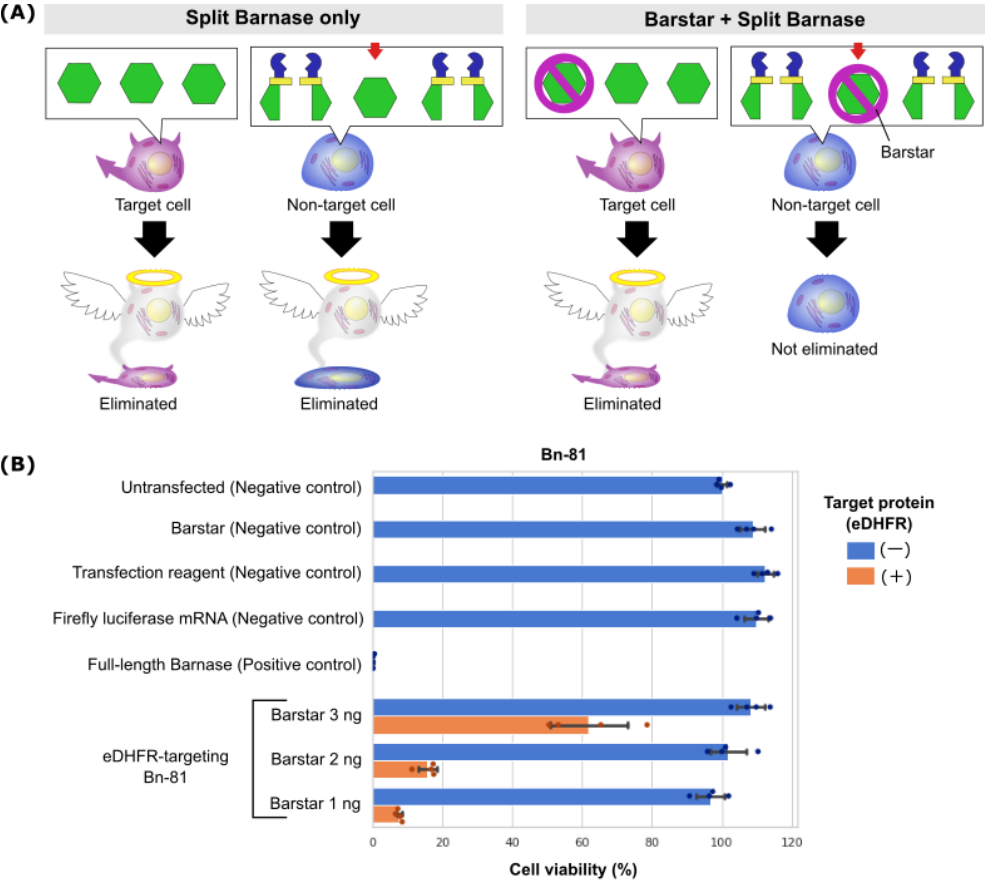
Figure 3. Reduction of off-target cytotoxicity by cotransfection of Barstar. ( A ) Schematic diagram showing reduced off-target cytotoxicity by cotransfection of Barstar. A small portion of split Bn can be reconstituted into full-length Bn even in nontarget cells (indicated with a red arrow), which causes undesirable off-target cytotoxicity. The cotransfection of a small amount of Barstar can sufficiently inhibit the full-length Bn in nontarget cells. In contrast, owing to high protein splicing efficiency in target cells, such a small amount of Barstar is insufficient to inhibit on-target cytotoxicity. ( B ) Cell viability assay results from cells transfected with Bn-81 and Barstar mRNA. Cell viability was measured 2 days after cotransfecting HeLa cells with Bn-81 (45 ng/well of both N- and C-terminal split Bn-81), eDHFR (10 ng/well) and Barstar mRNA (3, 2, or 1 ng/well). Firefly luciferase mRNA (90 ng/well), Barstar mRNA (90 ng/well), and the transfection reagent without mRNA were used as negative controls. Full-length Bn (90 ng/well) was used as a positive control.